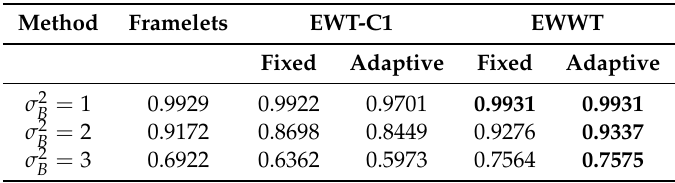
Table 7. Final comparisons for deconvolution for different level of blur ( σ 2 given in